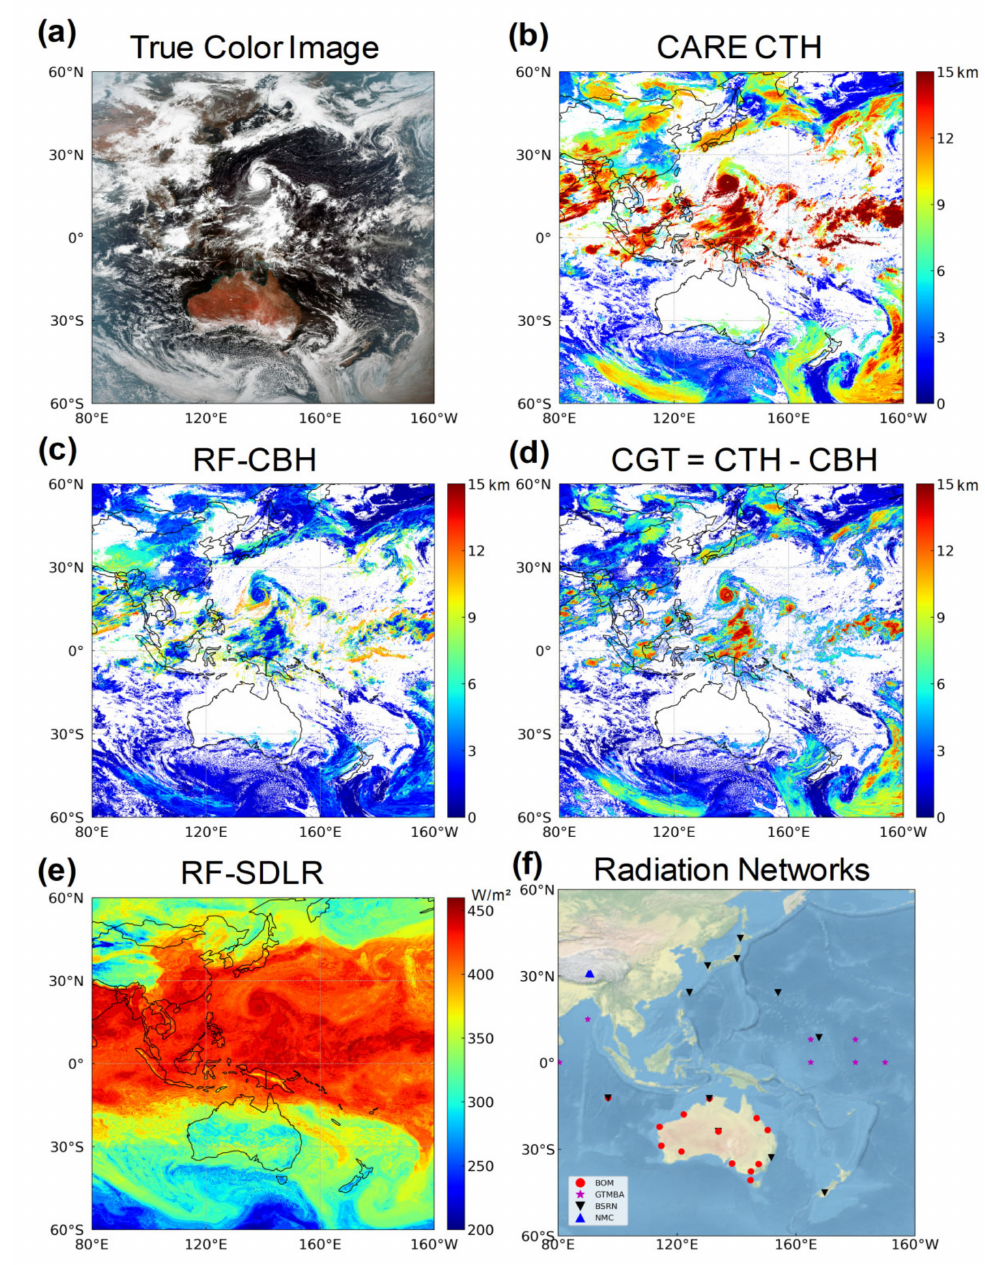
Figure 3. Spatial features of the H-8 full-disk cloud geometric properties and SDLR on September 1, 2018: ( a ) bands 3, 2, and 1 for RGB of the H-8 true color image; ( b ) CARE cloud top height product; ( c ) H-8 cloud base height derived using the RF models; ( d ) cloud geometry thickness derived from the difference between CTH and CBH; ( e ) H-8 SDLR derived using the RF models; and ( f ) spatial distribution of radiation stations from four networks (BOM, GTMBA, BSRN, and NMC) used to validate the performance of the estimated SDLR. Different symbols stand for various